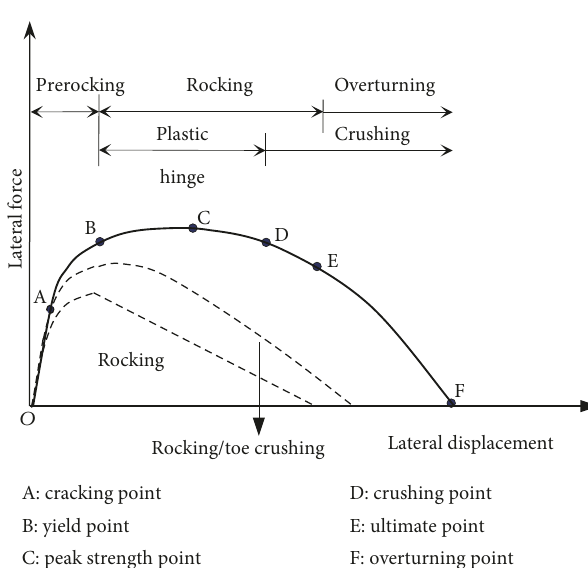
Figure 6: Excepted lateral force-displacement of rocking masonry